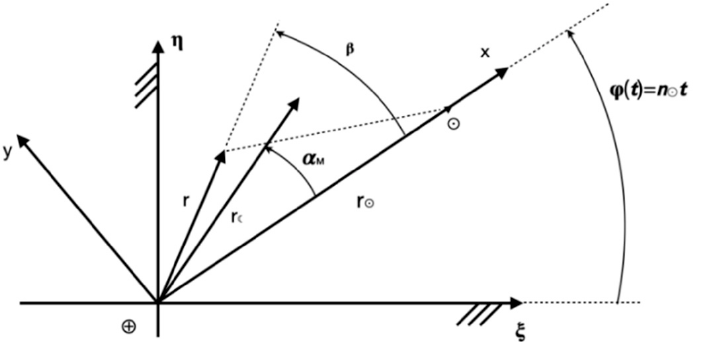
Figure 1. Coordinate systems: xCy ( z )—geocentric non-inertial, uniformly rotating, basic in terms of describing the motion of the center of mass of the spacecraft; ξ C η ( ζ )—geocentric non-inertial, but with a constant direction of axes in inertial space (see Appendix B).